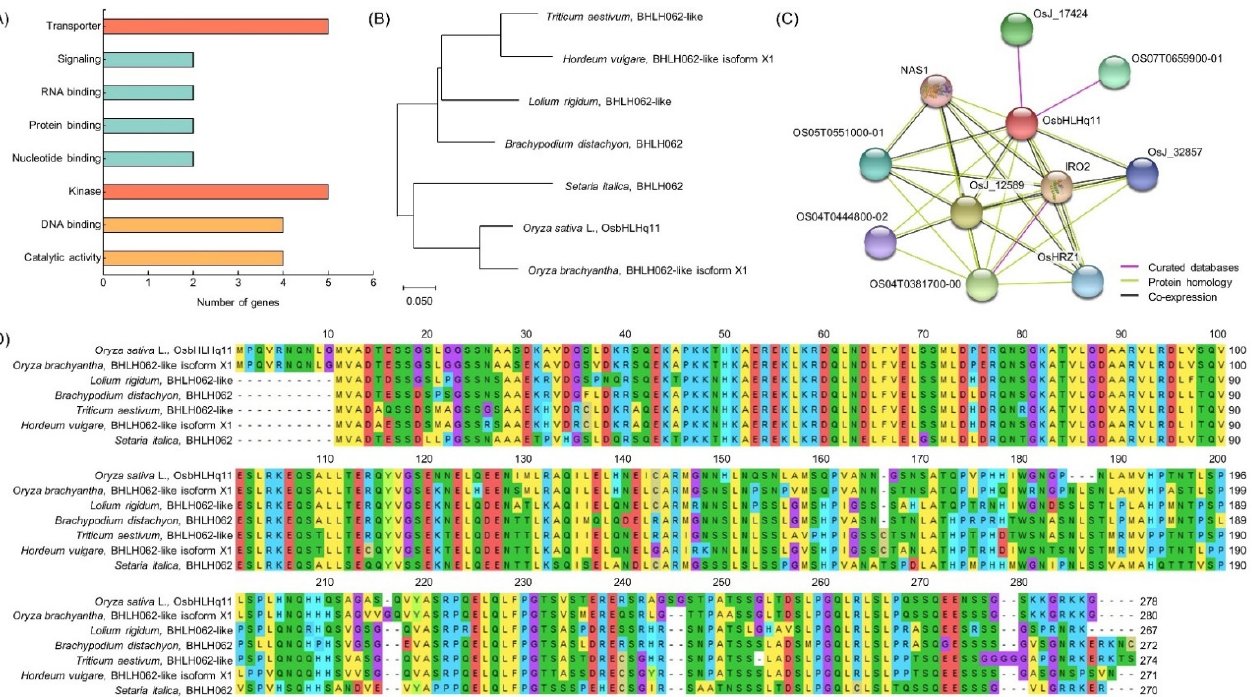
Figure 7. Predicting the function of OsbHLHq11. ( A ) QTL mapping result of chlorophyll content- related gene distribution. ( B ) Protein interaction of OsbHLHq11. ( C ) Phylogenetic tree of OsbHLHq11 and homology gene. The phylogenetic tree was constructed with 1000 bootstrap replicates. The results of BLAST analysis through NCBI showed that OsbHLHq11 has a very similar sequence to that of BHLH62. Genetic similarity between LOC_Os11g38870 and BHLH62 present in Triticum dicoccoides, Triticum aestivum, Hordeum vulgare, Zea mays, and Setaria italica, confirmed by phylogenetic tree analysis. OsbHLHq11 belonged to the same group as the Setaria italica . ( D ) Multiple sequence alignment of OsbHLHq11.